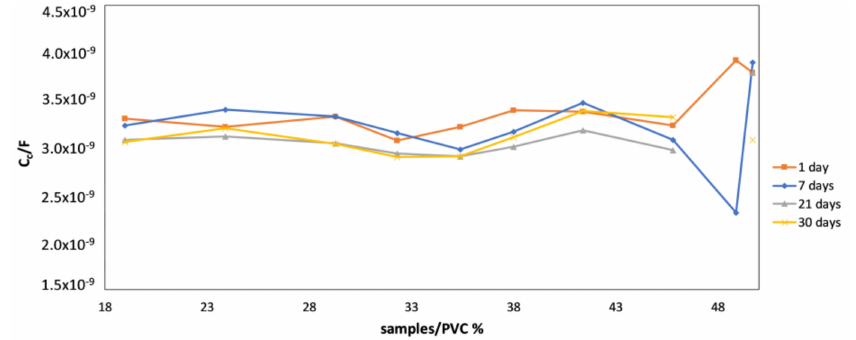
Figure 6. Coating capacitance vs. di ff erent PVC values ( x -axis, see Table 1) and at di ff erent times of film formation (see legend).